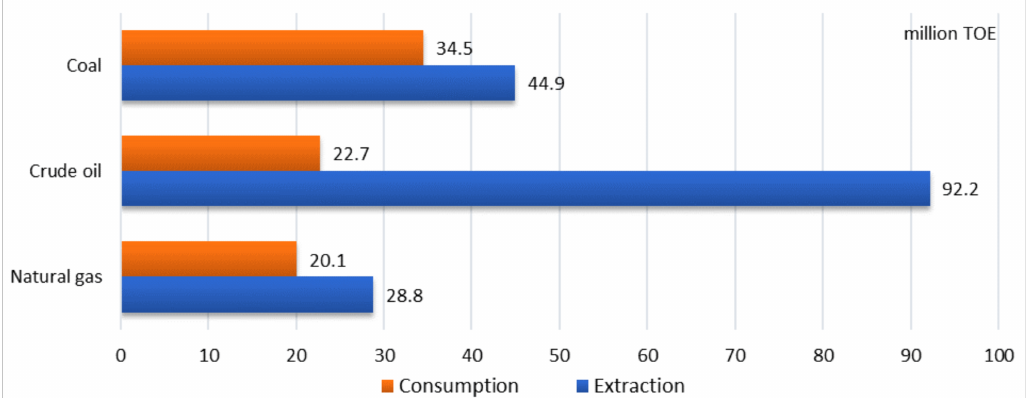
Figure 1. Dynamics of gross consumption and production of fuel and energy resources in Kazakhstan in 2019, million tons of oil equivalent (TOE). Source: compiled by the authors based on data from